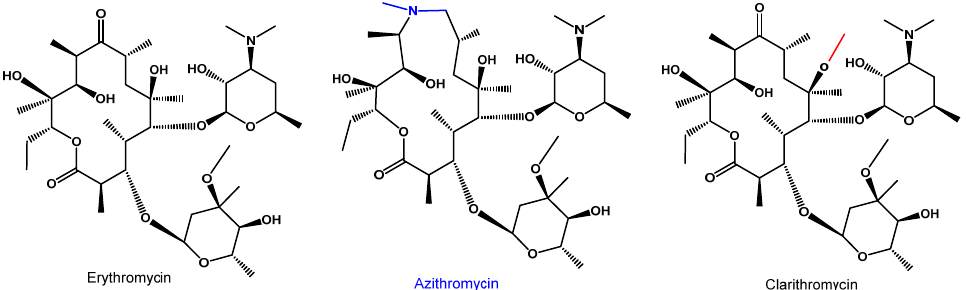
Figure 1. Molecular structure of the mother macrolide molecule erythromycin and its semisynthetic derivatives azithromycin (15-membered) and clarithromycin (14-membered). Blue and red colors in the structures represent modifications of the mother molecule (black).